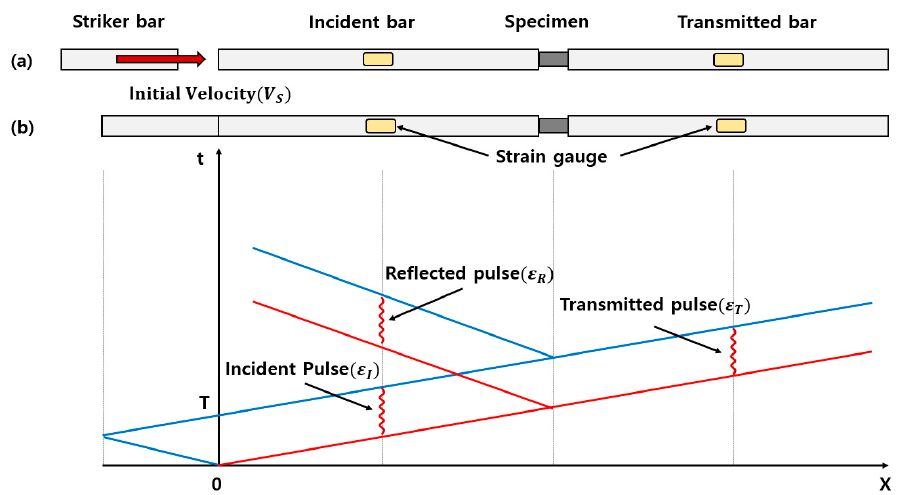
Figure 1. ( a ) Schematic diagram of an SHPB; and ( b ) the SHPB wave propagation after the impact of the striker bar [18].